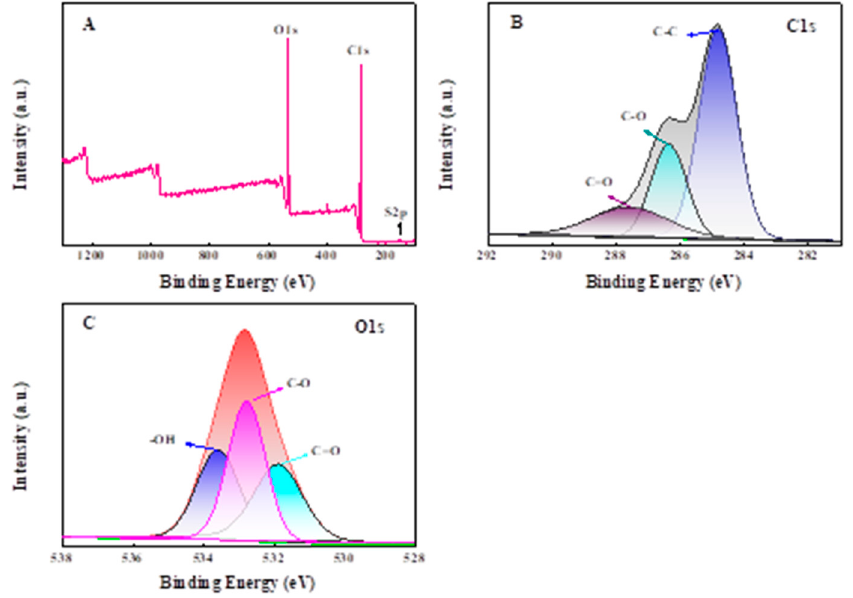
Figure 5. XPS analysis: ( A ) survey XPS spectra of CPP200; and XPS-peak-differentation-imitating analyses of C1s ( B ) and O1s ( C ).